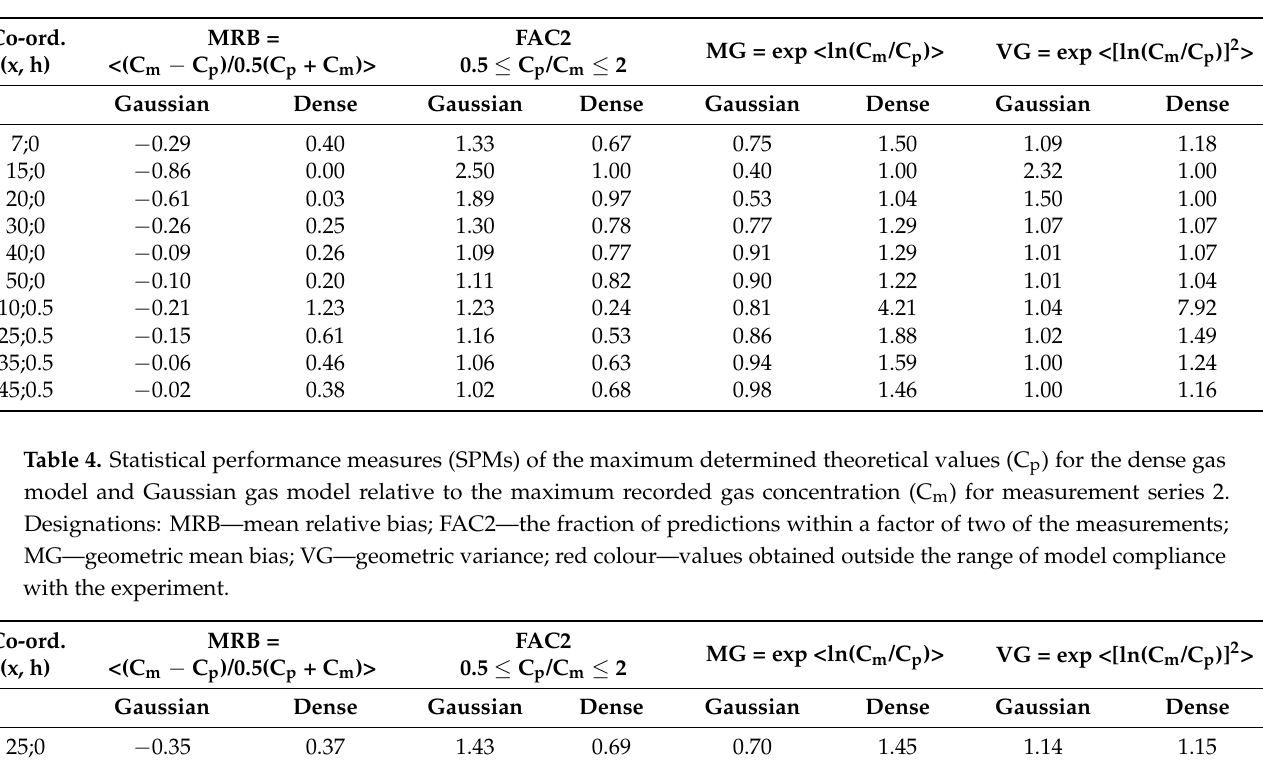
Table 3. Statistical performance measures (SPMs) of the maximum determined theoretical values (C p ) for the dense gas model and Gaussian gas model relative to the maximum recorded gas concentration (C m ) for measurement series 1. Designations: MRB—mean relative bias; FAC2—the fraction of predictions within a factor of two of the measurements; MG—geometric mean bias; VG—geometric variance; red colour—values obtained outside the range of model compliance with the experiment.